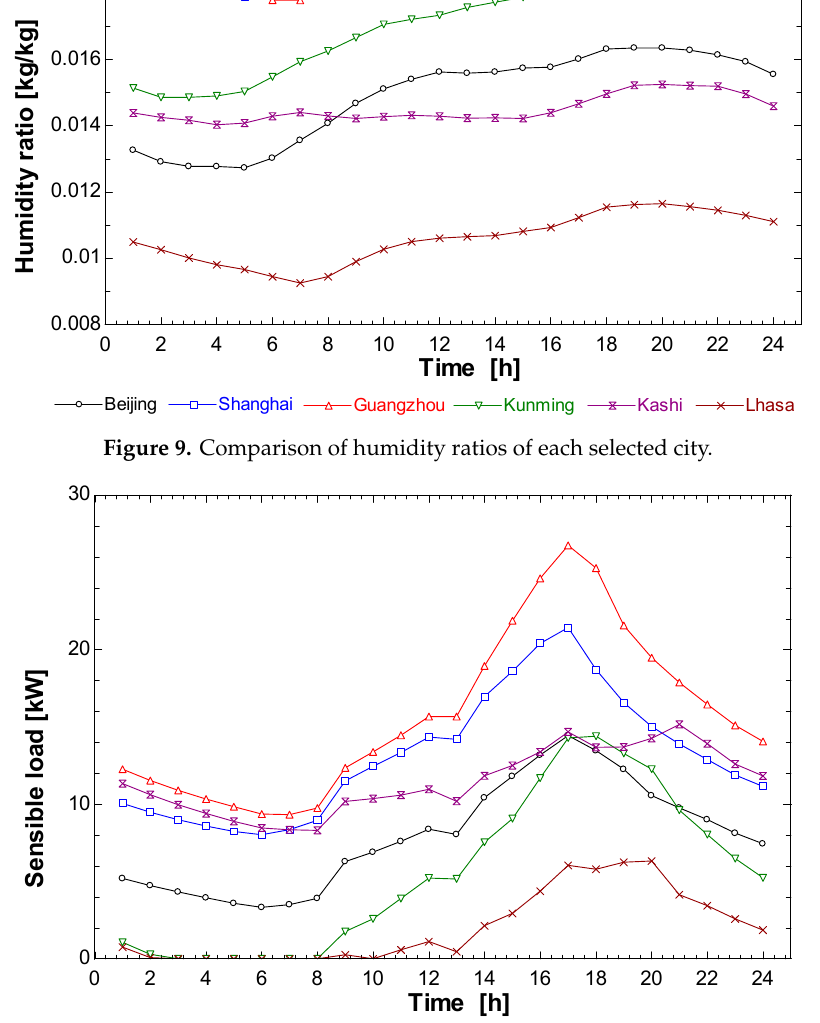
Figure 10. Comparison of cooling load of each selected city.